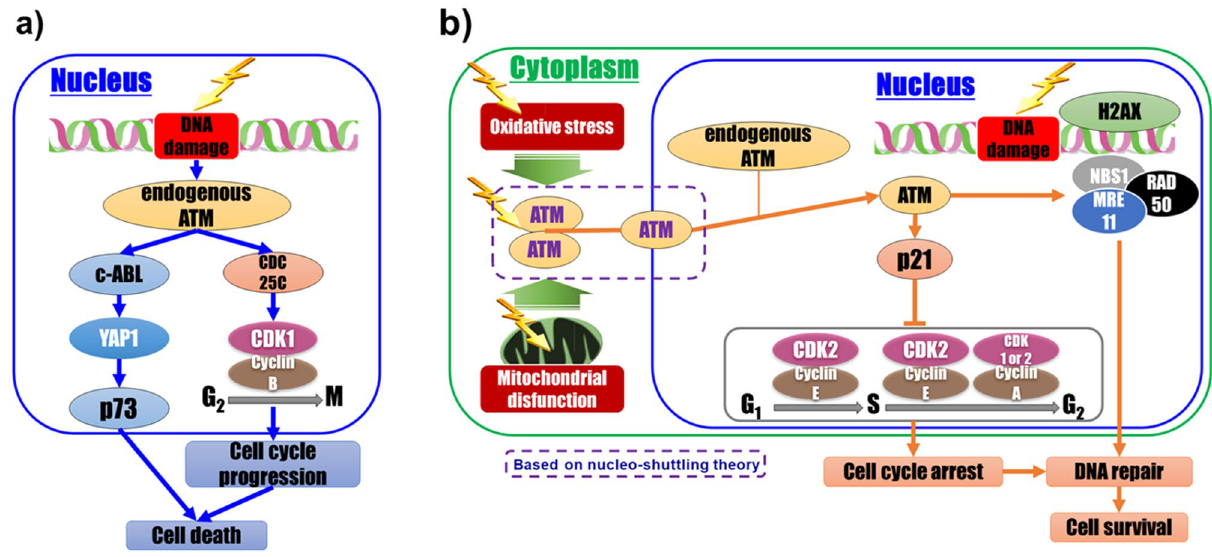
Figure 7. Schematic illustration of the possible cell death-related mechanisms involving cellular signal transduction under exposure to low-dose X-rays. Cell death-related possible mechanisms in nucleus ( a ) and whole-cell ( b ) irradiation with low dose X-ray microbeams. Although functions of the molecules indicated in white color font in the pathway and nucleo-shuttling of ATM were not directly confirmed in this study, they are shown based on the knowledge reported thus far, as described in the